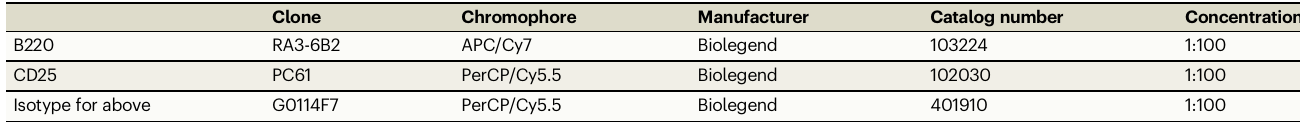
Table 2 | Murine antibodies used in fl ow cytometry